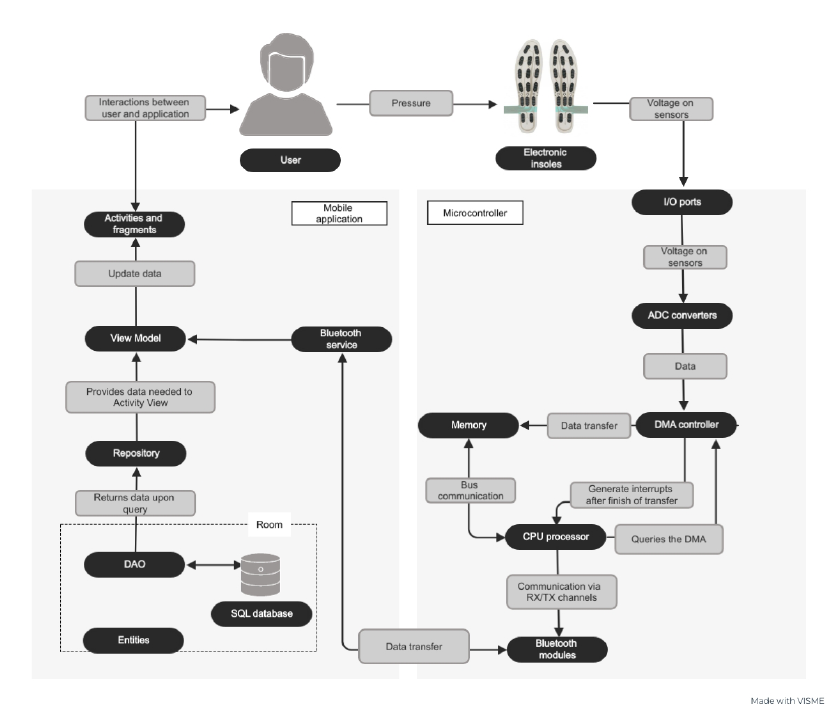
Figure 2. System architecture (View Model—communication center between the user interface and the repository, it simultaneously caches the latest data from the so-called LiveData and passes it to the repository. Repository—manages multiple data sources, in this case, localization services, Bluetooth, and database. Room—the database layer that makes them easier to store, uses DAO (Data Access Object) to query the SQL database. Data Access Object maps SQL queries to functions that can be called in the program. Entities—annotated classes that describe the database table).